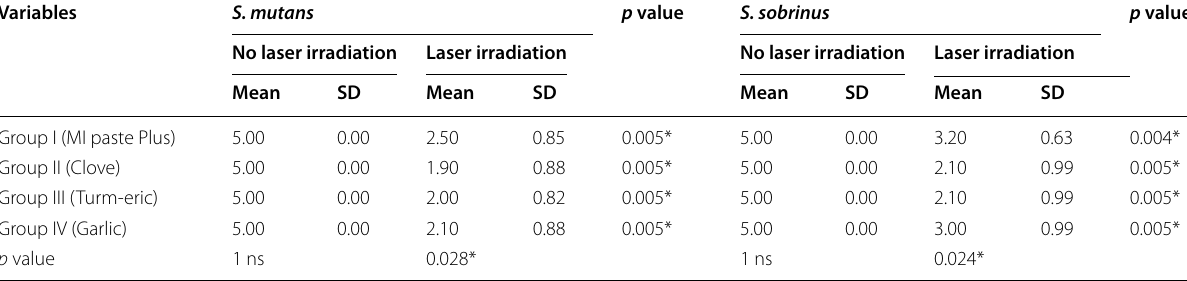
*Significant ( p < 0.05)/ns; non-significant ( p > 0.05)